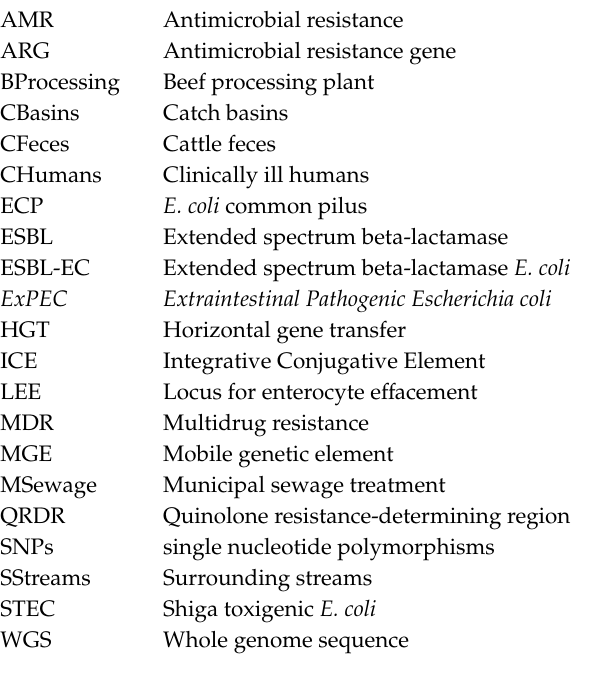
Table S1: Antimicrobial resistance phenotypes of presumptive ESBL– E. coli . Table S2: Resistance determinants identified in presumptive ESBL– E. coli . TableS3: Whole genome sequencing assembly data for 162 presumptive ESBL– E. coli isolates. Table S4: Identification of mutations in the quinolone resistance-determining regions of presumptive ESBL– E. coli . Table S5: Least square means comparing antimicrobial resistance gene prevalence in cattle versus human isolates. Table S6: Genotype and phenotype comparison of presumptive ESBL E. coli isolates from multiple sources of the One Health continuum. Table S7: Serogroup and ST type of in presumptive ESBL– E. coli. Table S8: Di ff erences between plasmid least square means estimates of the e ff ect of isolate from cattle versus human sources. Table S9: Plasmids identified in presumptive ESBL– E. coli. Table S10: Integrative conjugative elements identified in presumptive ESBL– E. coli. Table S11: Virulence determinants identified in presumptive ESBL– E. coli . Table S12: Di ff erences between virulence determinants identified in presumptive ESBL– E. coli isolated from di ff erent sources across a One Health